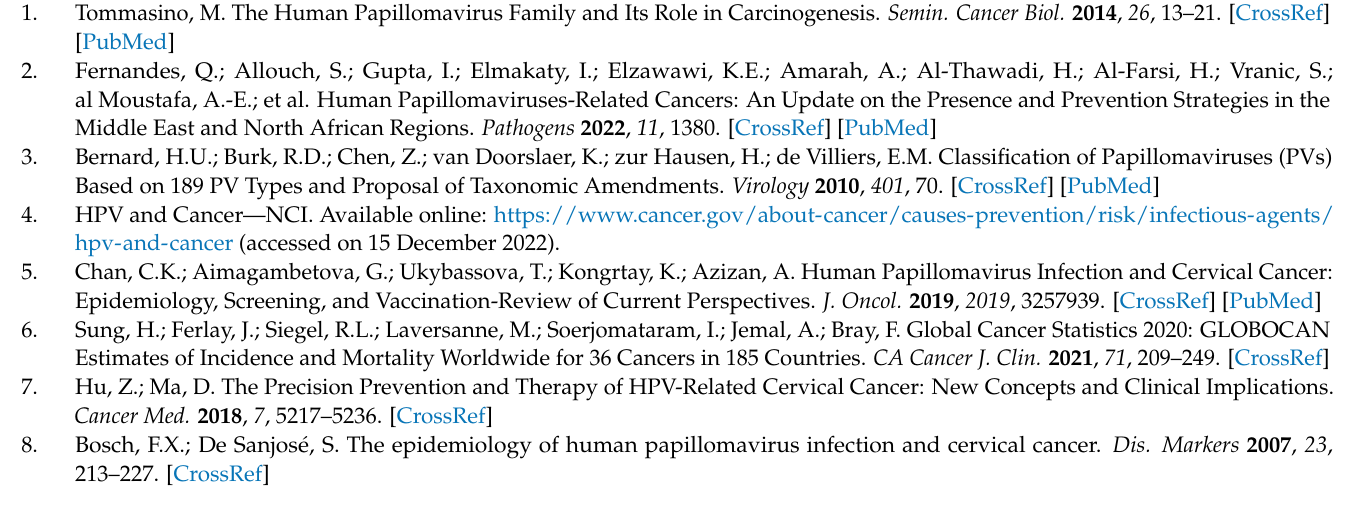
Figure S3: Electrophoresis gel image for TGFB1 rs1800469 (c.–1347C>T) genotyping, Figure S4: Electrophoresis gel image for TGFB1 rs1800470 (c.29C>T) genotyping, Figure S5: Electrophoresis gel image for TGFB1 rs1800471 (c.74G>C)